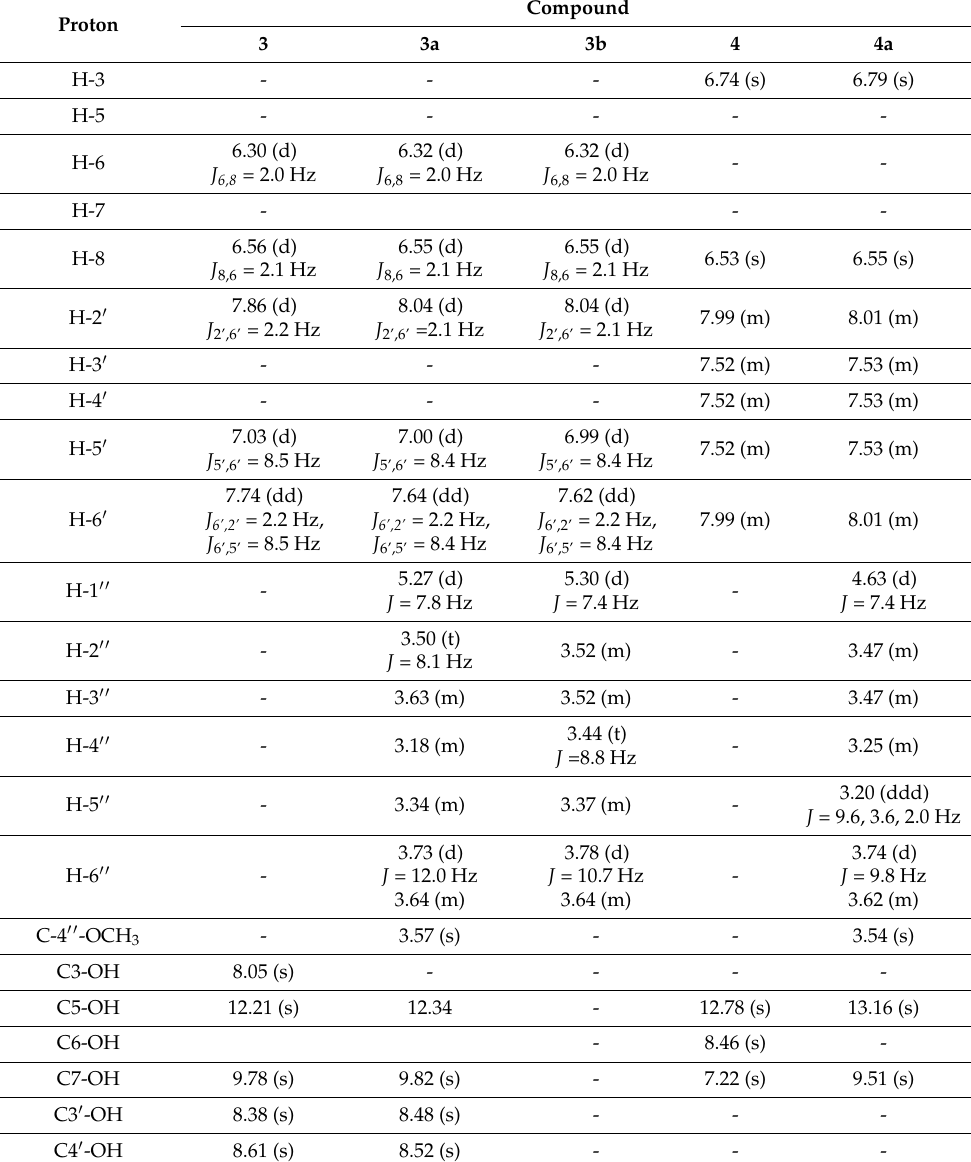
Table 3. 1 H-NMR shifts ( δ ) of quercetin ( 3 ) 1 and baicalein ( 4 ) 2 and products of their biotransformations